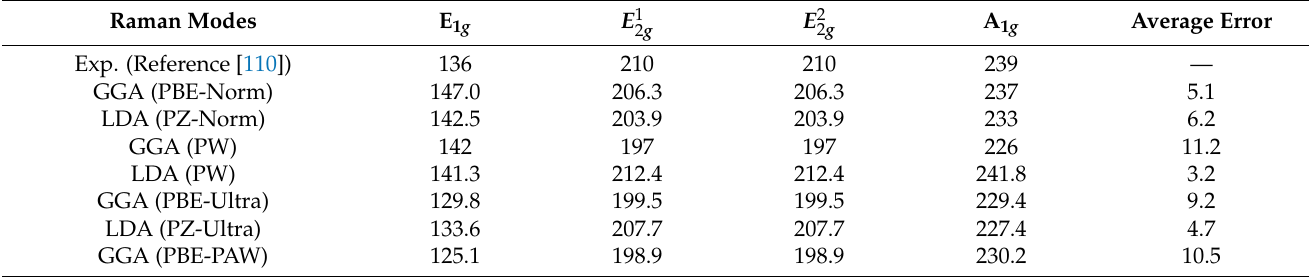
Table 2. Raman modes for TaSe 2 unit cell. As the average error (computed as the average of the absolute differences between experimental and DFT result for each mode) shows at a glance, using LDA with PW parametrization leads to Raman frequencies overall closer to the experimental